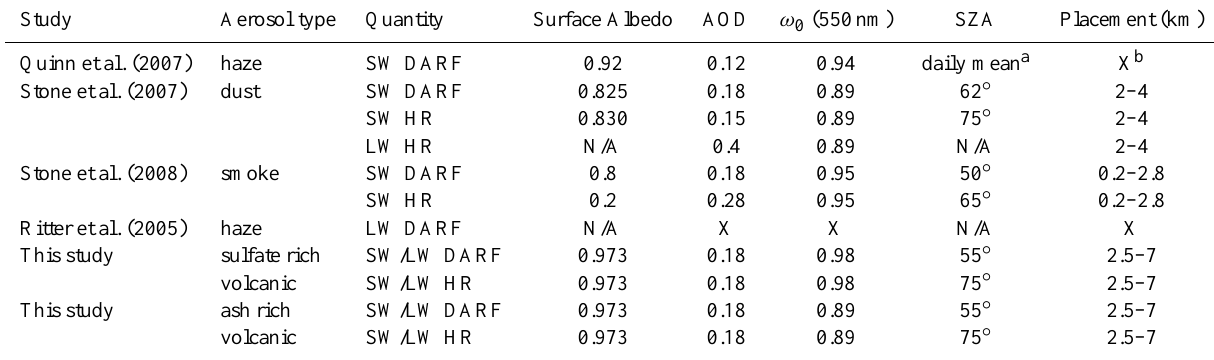
Table 4. Studies chosen for comparisons of DARF and heating rates (HR) of Arctic aerosols, along with aerosol types, surface albedo, AOD at 500 or 550nm, ω 0 (singe scattering albedo) at 550nm, solar zenith angle (SZA), vertical plume thickness and placement within the atmosphere that were used. Boxes filled with an X indicate information was not available.